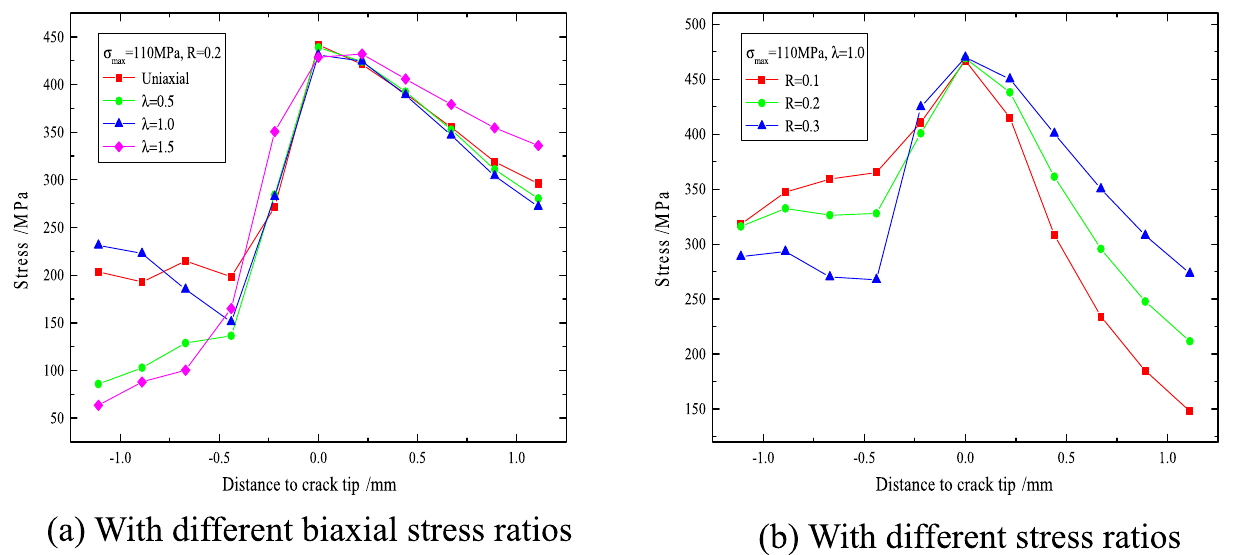
Fig. 18 Distribution of residual stress at the crack tip along the crack propagation direction under different